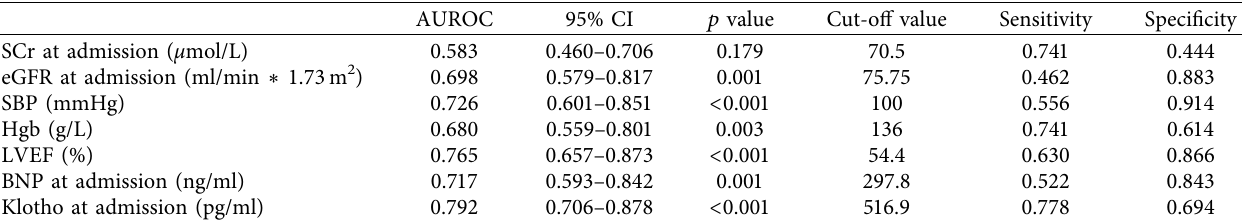
Table 3: Te areas under the receiver operating characteristic curves for serum levels of α -Klotho and other conventional risk factors to predict AKI after AMI.